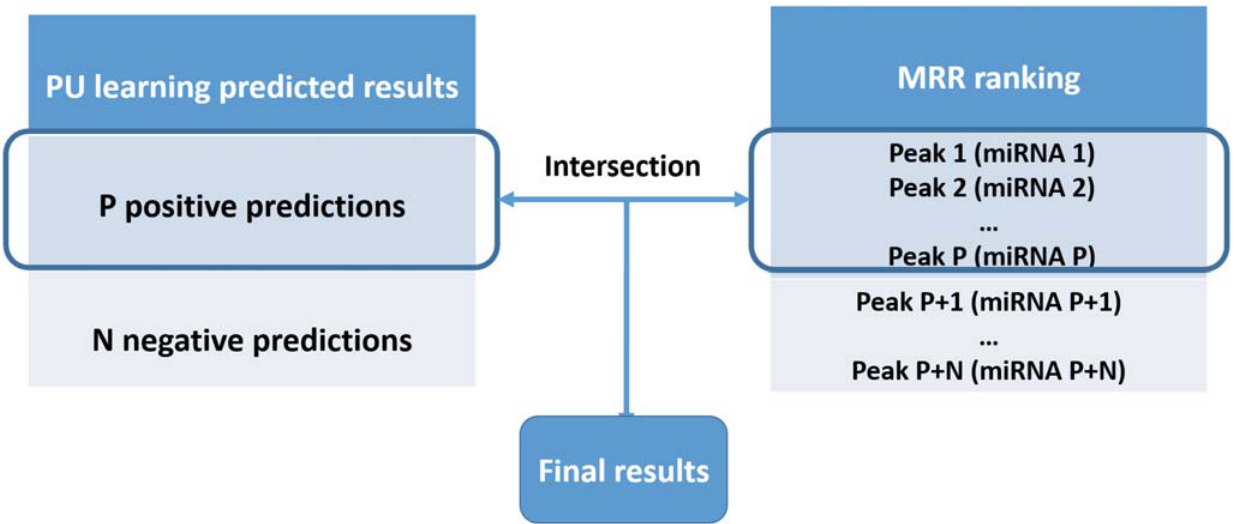
Fig 2. The illustration of the merge step. We got P positive predictions from PU learning and a list of ranked candidate peaks by MRR ranking. Then we took the top P peaks from the list and intersected them with the P positive predictions from PU learning. The intersection is the final result.